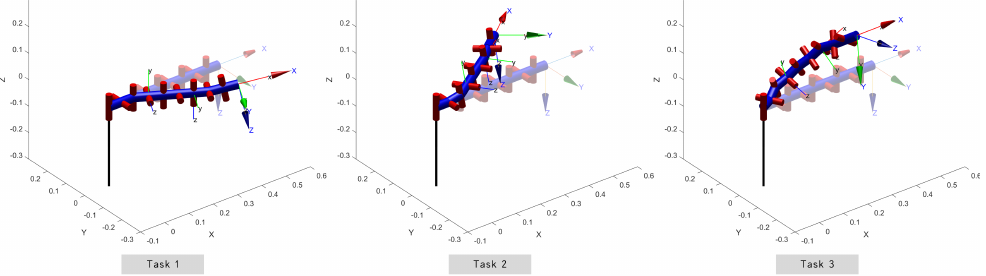
Figure 5. The three reaching tasks to be performed. The translucent pose is the initial configuration from which the robot is to actuate towards the opaque pose.